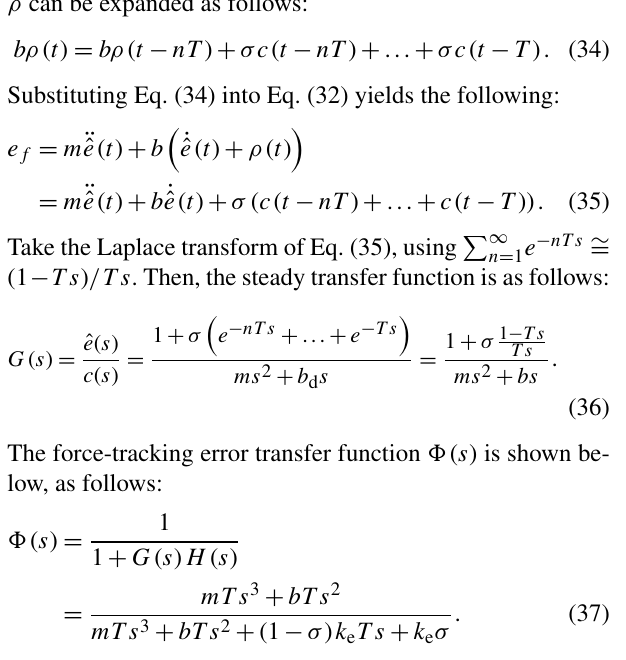
a better motion-tracking ability. Therefore, this part mainly analyses the control performance of impedance